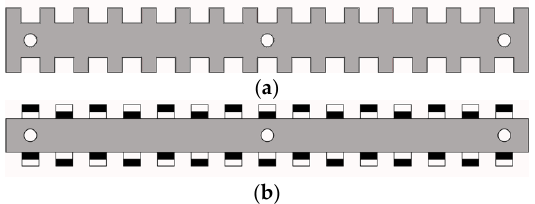
Figure 2. Mover structures ( a ) linear switched reluctance motor (LSRM) ( b ) PM-LM.